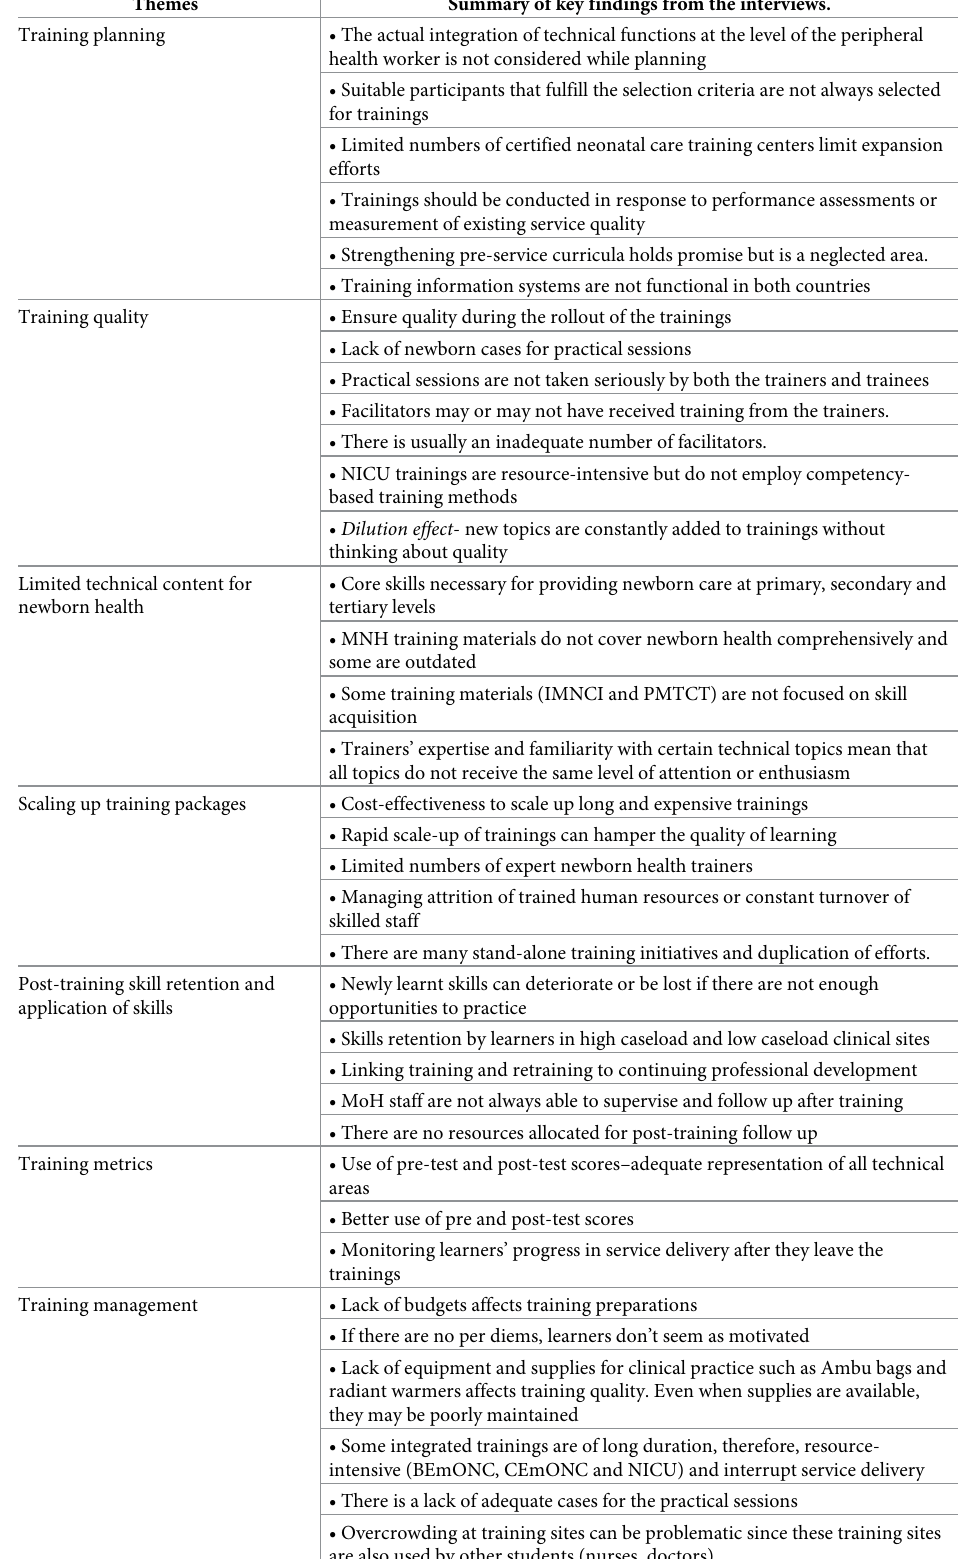
Table 3. Summary of qualitative